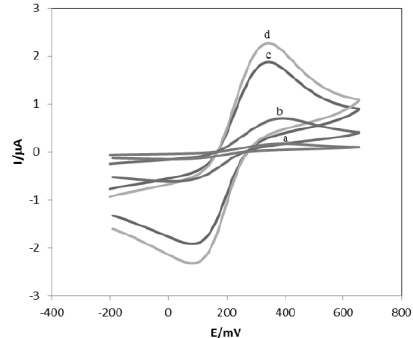
Figure 3. Cyclic voltammograms of different modified electrodes: a) MWCNT b) MWCNT(SH), c)MWCNT(SH)Au and d)MWCNT(SH)Au/IL. Supporting electrolyte=0.1M KCl containing 1mM of (FeCN) 6-3/-4 ; scan rate=80mV/s.